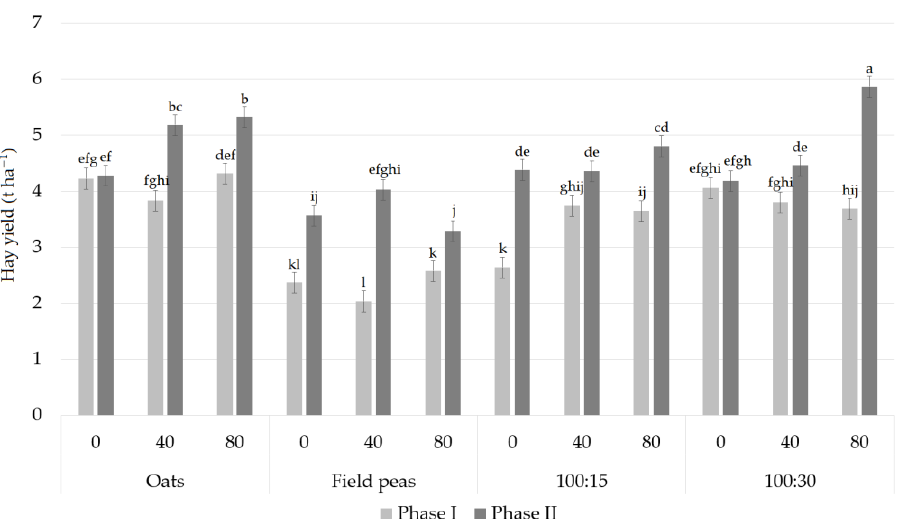
Figure 3. Hay yield of sole crops and their mixture under nitrogen fertilizer (0 kg ha −1 , 40 kg ha −1 , 80 kg ha −1 ) and two mowing phases (2018); error bars — standard error; a – l — significant differences between different treatments, a representing the highest value, etc.